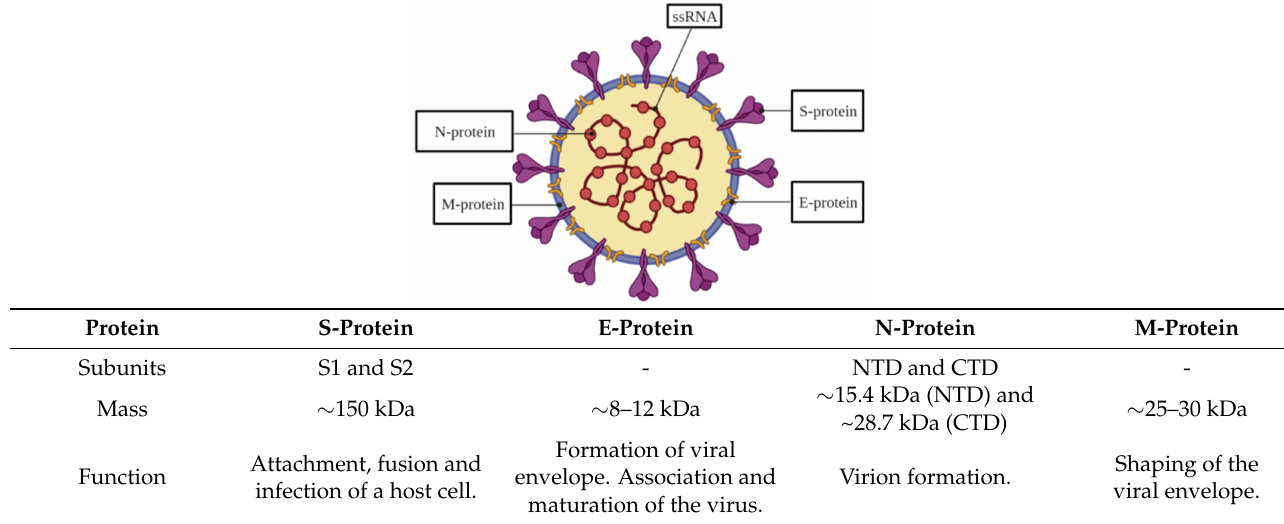
Table 1. Severe acute respiratory syndrome coronavirus 2 (SARS-CoV-2) structural proteins location, structure, mass and